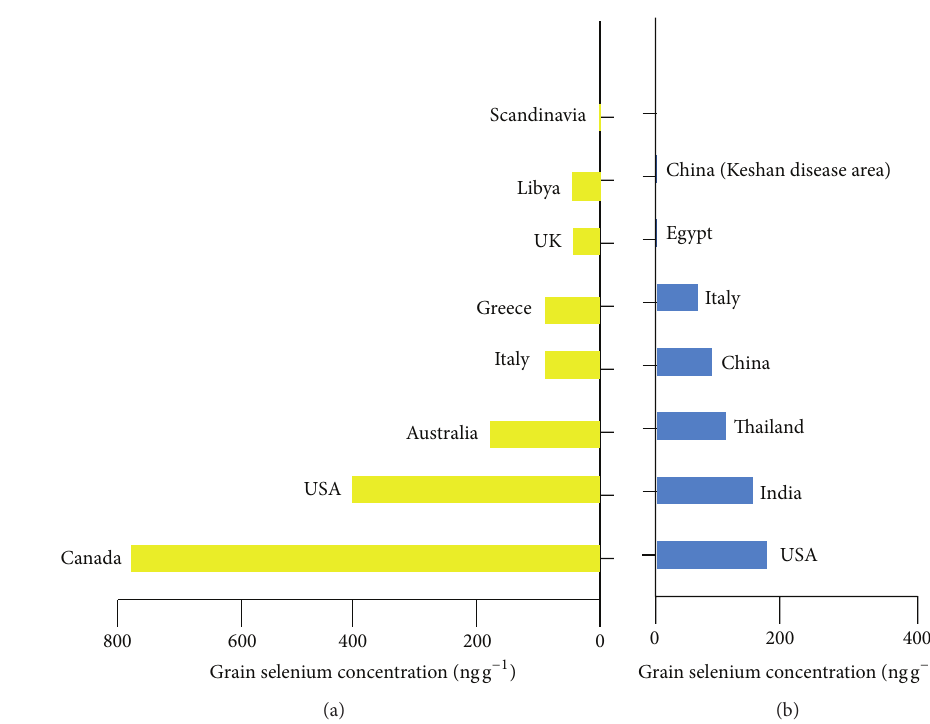
Figure 3: Comparison of Se levels in wheat (a) and rice grains (b) in different countries over the last 40 years (extracted from Zhu et al. [35]).